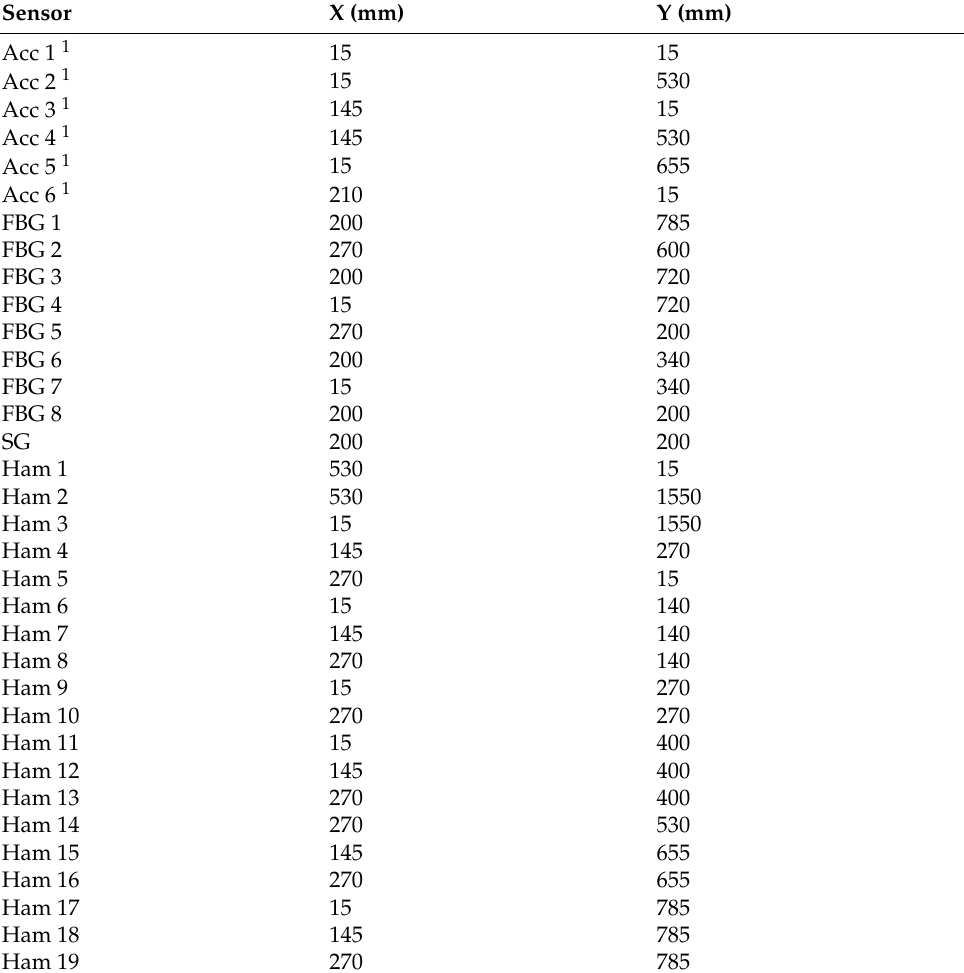
Table 1. Coordinates of sensor locations and hammer impact